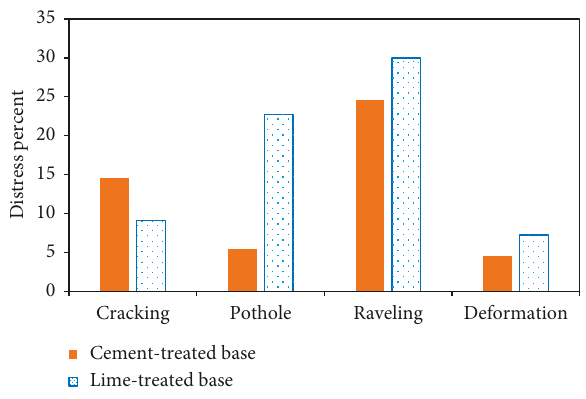
Figure 20: Field performance results. Figure 22: Typical cracking in test section in May 2017.